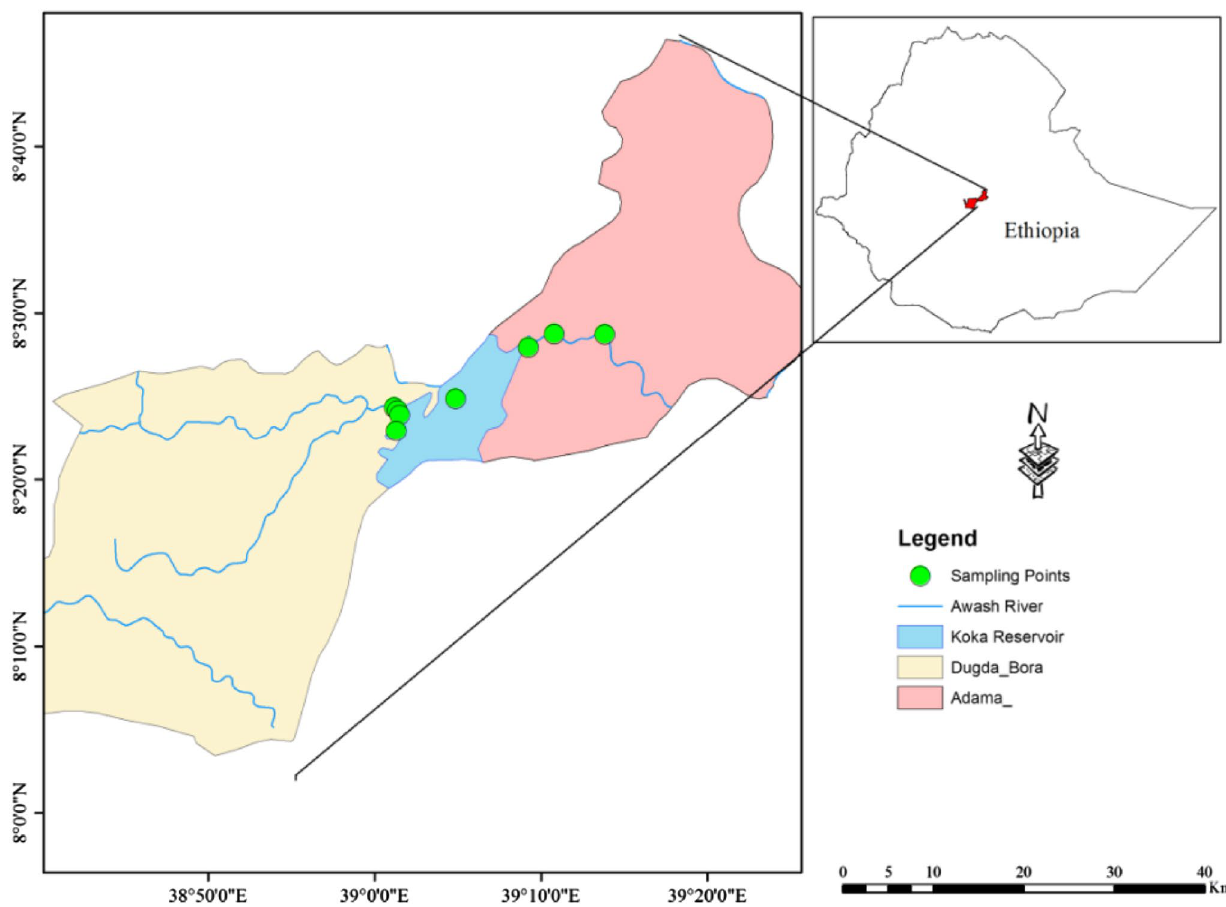
Fig. 1 Map of the study area with water sampling